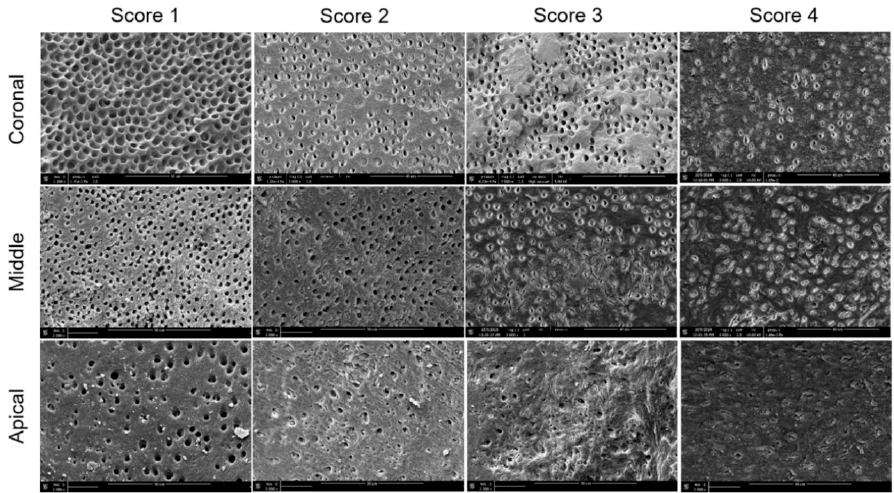
Figure 2. Representative scanning electron microscopy micrographs ( × 2000 magnification) of smear layer scores at the coronal, middle, and apical thirds.